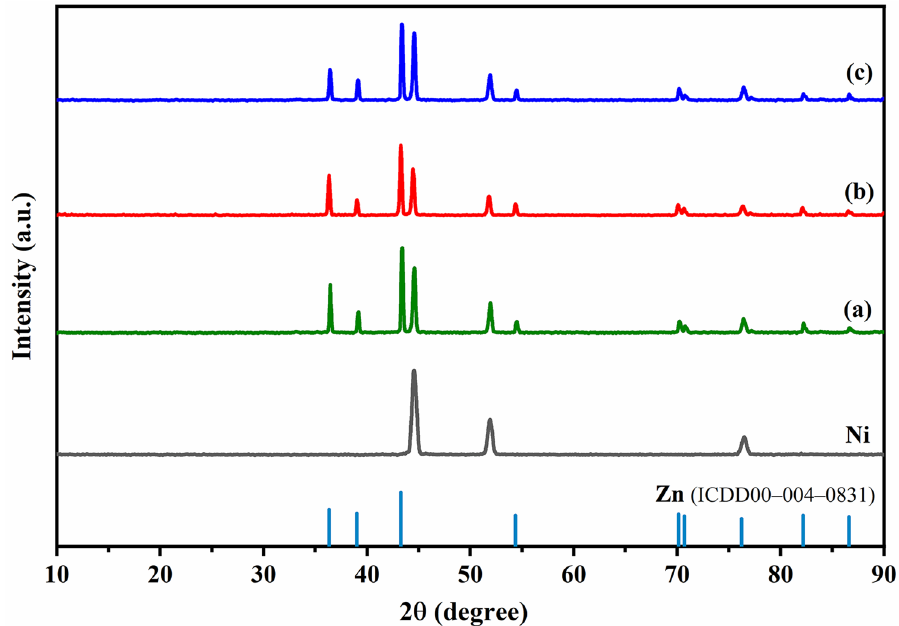
Figure 2. X-ray Diffraction (XRD) patterns ( a ) Zn ( b ) Zn-PPy, and ( c )